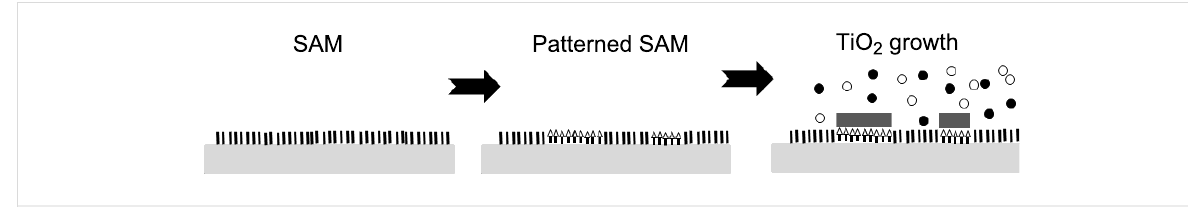
Figure 5: Partial oxidation of SAMs at predesigned locations followed by TiO 2 growth on the partially oxidized